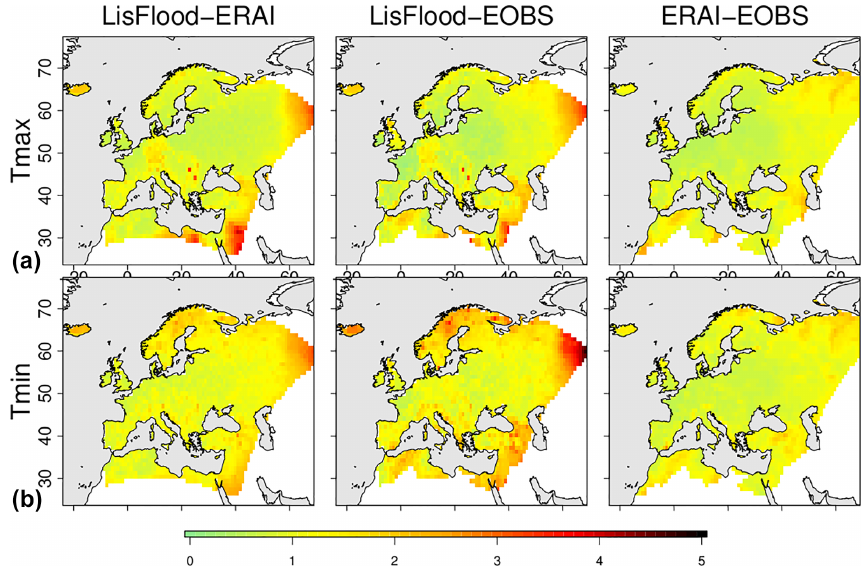
Figure 3. Mean absolute error of temperature (in K) between the three datasets, calculated from 1995 to 2015 for T min (a) and T max (b) . The datasets compared are indicated on the top of each